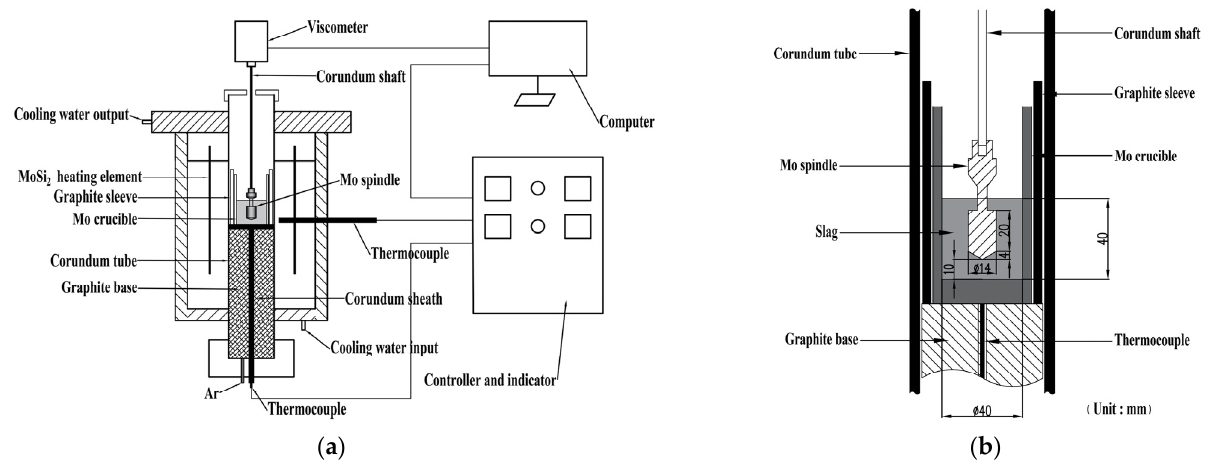
Figure 1. Schematic diagram of experiments device ( a ) and sizes of crucible and spindle ( b ).